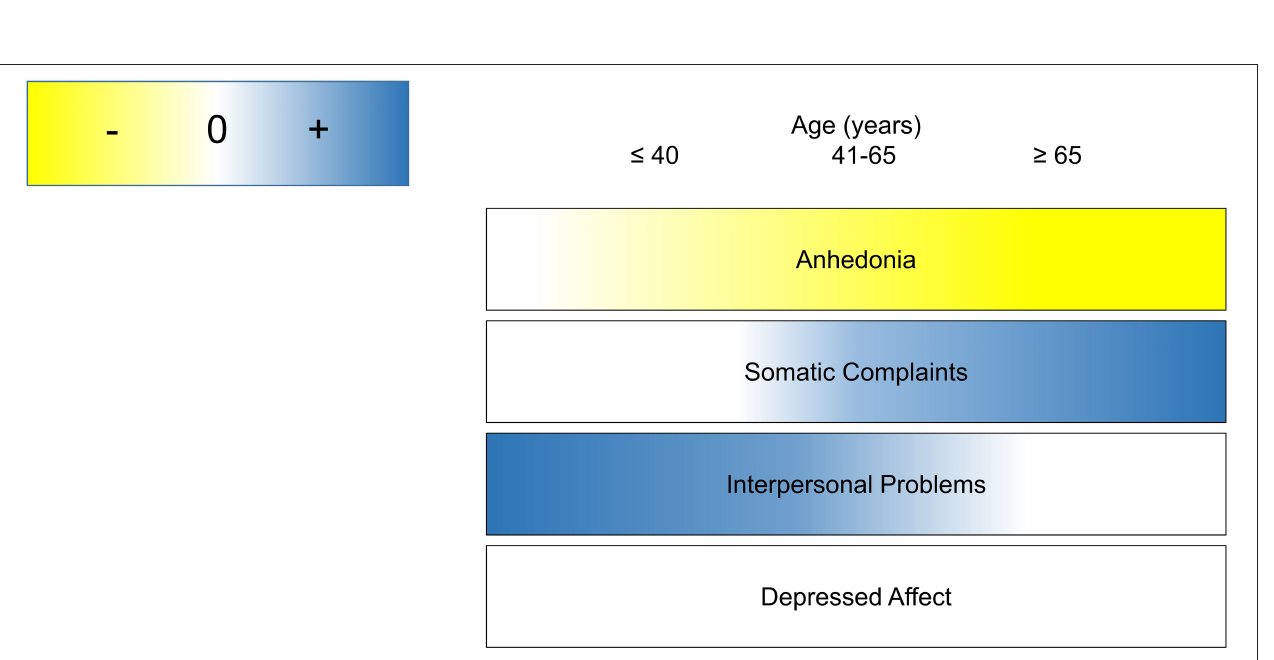
FIGURE 3 | Conceptual summary of age as a context for the role of inflammation in depressive symptom domains.